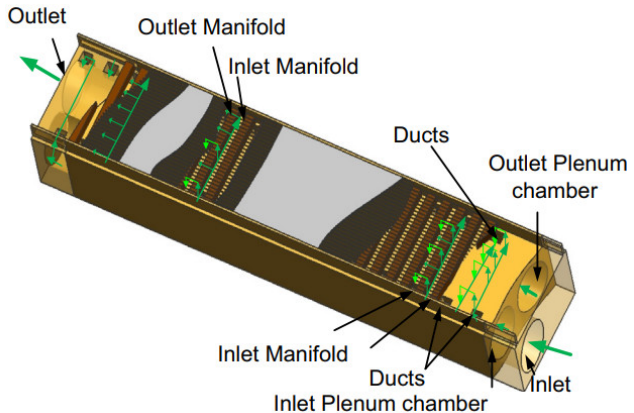
Figure 35. Schematic diagram of the multi-layer manifold microchannel testing unit [140]. Reprinted with permission from Ref. [140]. 2015, Elsevier.